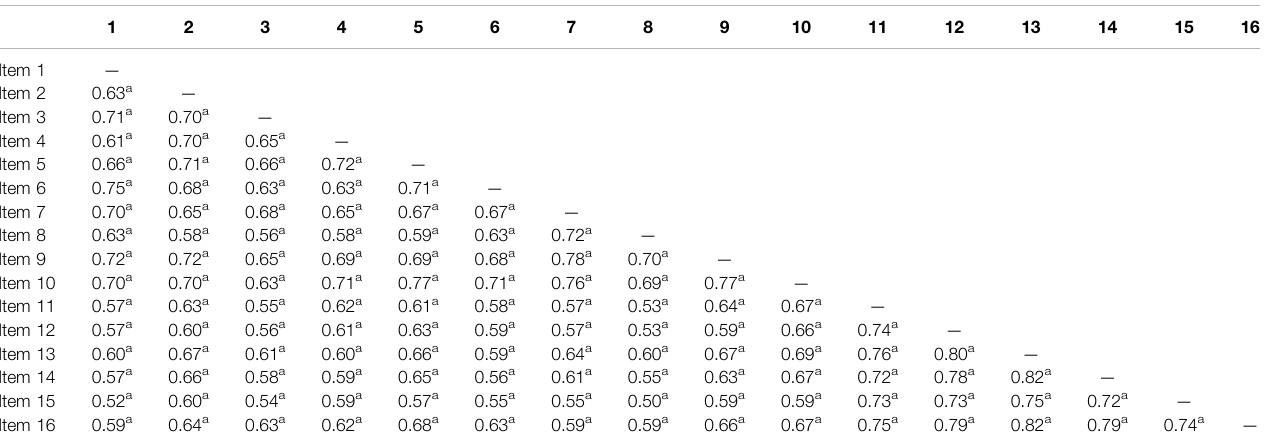
TABLE 3 | Intercorrelations between items of the CSTR using the polychoric correlation matrix.